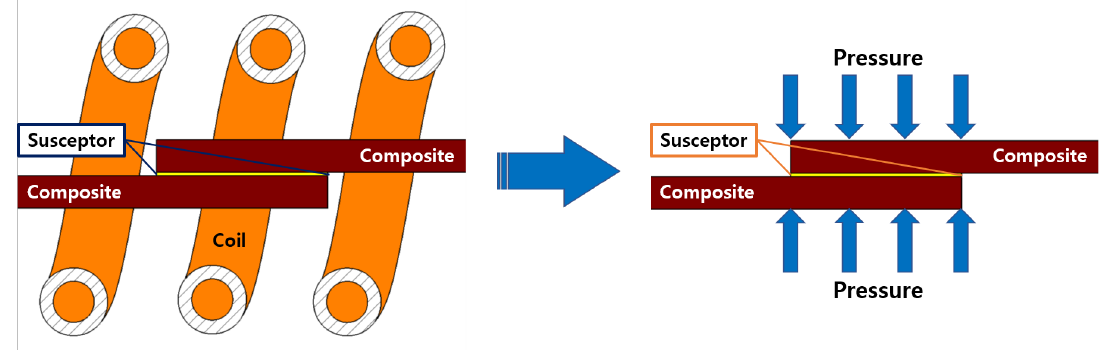
Figure 3. Induction welding